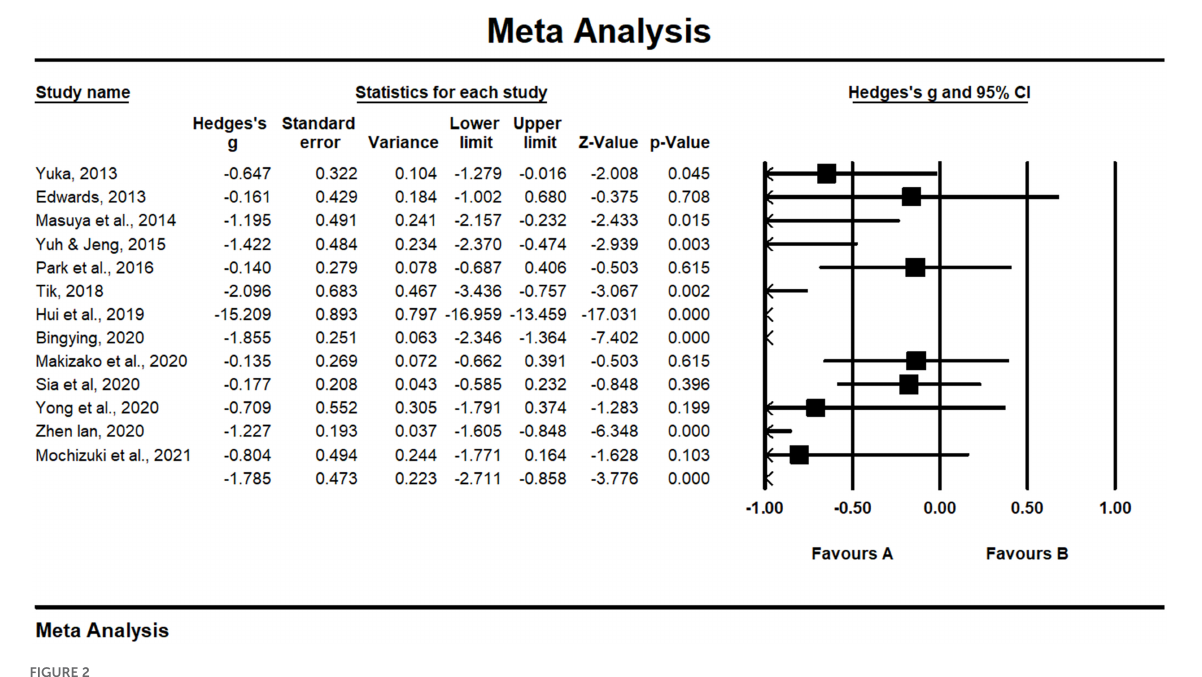
FIGURE2 Forest plot: HT group vs. control for depression scores (continuous outcome).